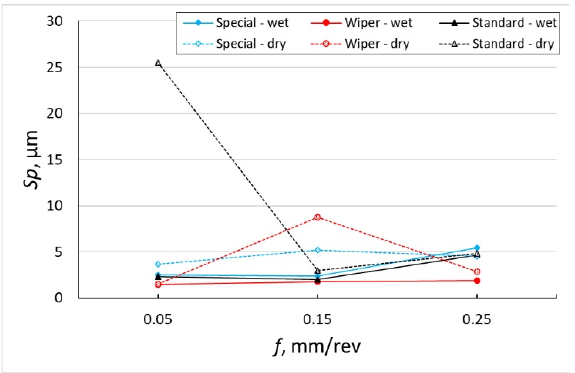
Figure 4. The impact of feed f on the variability of roughness parameter Sp .